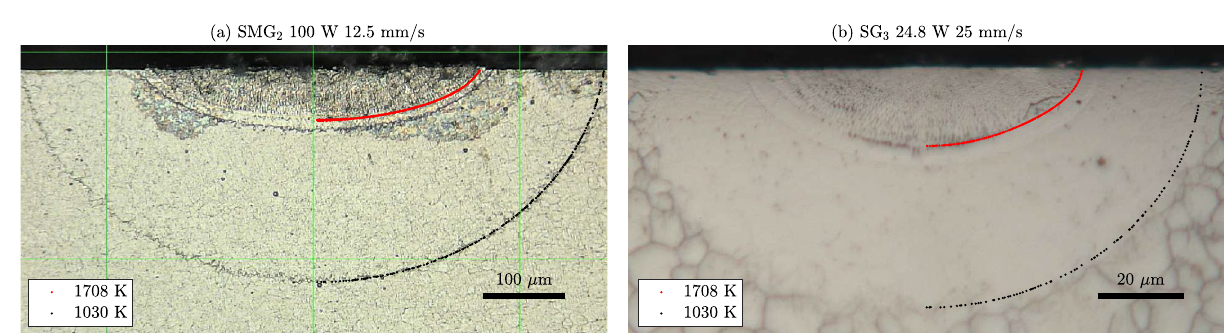
Figure 5. Time history of the temperature T , temperature gradient G , and cooling rate and SG 4 (right) cases. Shown are the histories at three different points at the locations sketched, as computed by the optimal (A1 and A2) and edge values (B1 and B2) of (α , z S ) for the convective model. Only the cooling down histories below the liquidus temperature are plotted.